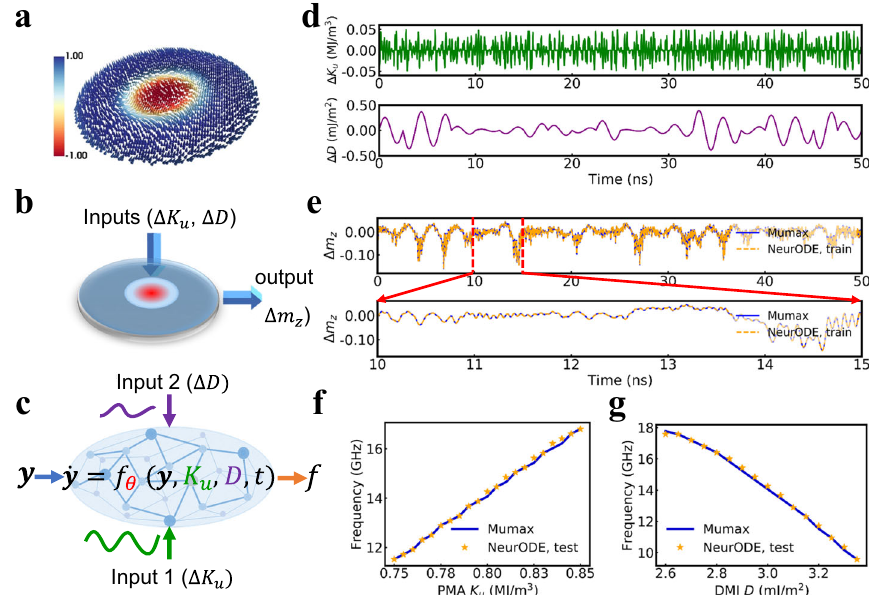
Fig. 1 Modeling a skyrmion-based device with micromagnetic simulation and Neural ODEs. a Magnetic skyrmion con fi gurations in a nano-disk. The color scale represents the out-of-plane component magnetization, and arrows denote the spin orientation. b Sketch of a device where a single skyrmion exists in the ferromagnetic layer. The behavior of the device depends on the Perpendicular Magnetic Anisotropy (PMA) constant (e.g., through VCMA effect) K u and the Dzyaloshinskii-Moriya Interaction (DMI) strength D . The output signal is the variation of perpendicular component of the mean magnetization Δ m z . c Sketch of a Neural ODE structure _ y ¼ f ; K ; D ; t Þ with Δ K u and Δ D as external inputs into the neural network. y is a vector of system dynamics θ ð y u and f is de fi ned by a neural network (see Fig. 2 for details of the modeling method). d Time-dependent random sine variation Δ K u ranging from − 0.05 MJ/ m 3 to 0.05 MJ/m 3 as an input (Input 1) and random sine variation Δ D ranging from − 0.4 mJ/m 2 to 0.4 mJ/m 2 as another input (Input 2) applied to the skyrmion system. Equilibrium values of K u = 0.8 MJ/m 3 and D = 3 mJ/m 2 are used. e Predicted training output of Δ m z by a Neural ODE in comparison with micromagnetic simulation (Mumax) results as a function of time. f , g Test results of the trained Neural ODE. The intrinsic response frequency of the skyrmion system for different values of K u in f and of D in g calculated by using the trained Neural ODE (orange star) and by micromagnetic simulations (blue). ‘ Neural ODE ’ is abbreviated to 'NeurODE' in the legends of the fi